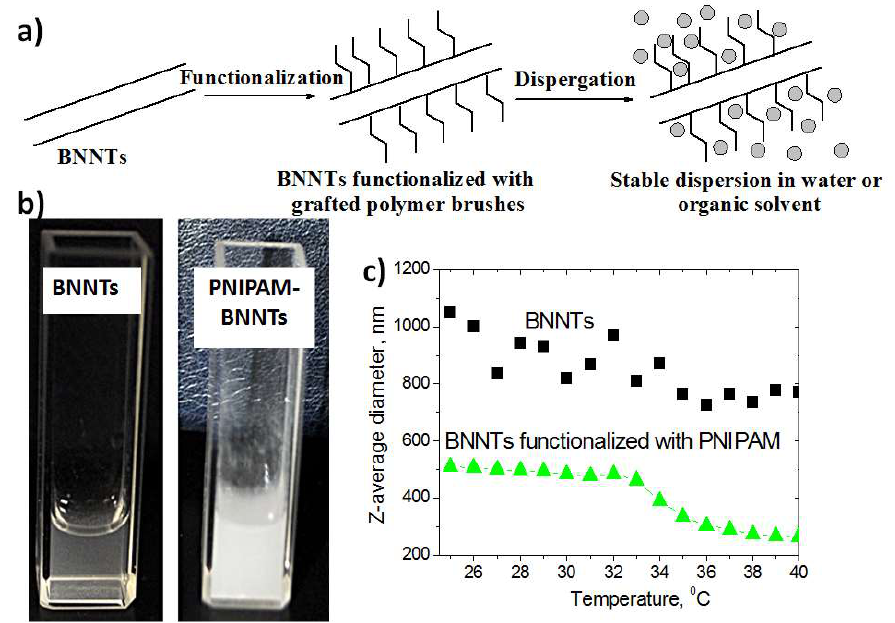
Figure 5. Fabrication of stable dispersion of the functionalized BNNTs ( a ), supernatants obtained after the water suspensions of native and PNIPAM-functionalized BNNT centrifugation ( b ), and Z-average diameters of the neat and PNIPAM-functionalized BNNTs at different temperatures ( c ). Adapted from [7].